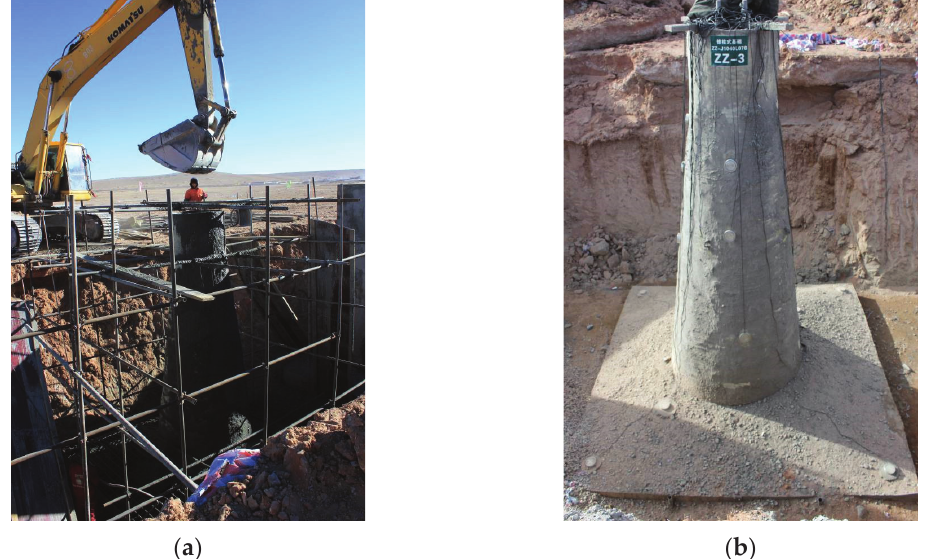
Figure 1. Construction of cone-cylinder foundation in Qinhai, China: ( a ) pouring concrete; ( b ) after concrete curing.